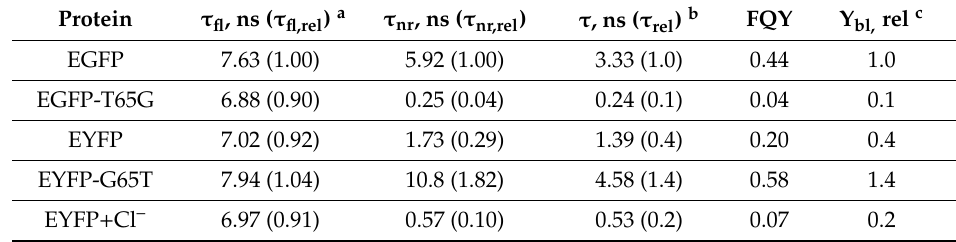
Table 4. Computed radiative and radiationless lifetimes of EGFP, EGFP-T65G, EYFP, EYFP-G65T, and EYFP + Cl – (in parenthesis, the values relative to EGFP are shown) and estimated photophysical parameters. Protein τ fl , ns ( τ fl,rel ) a